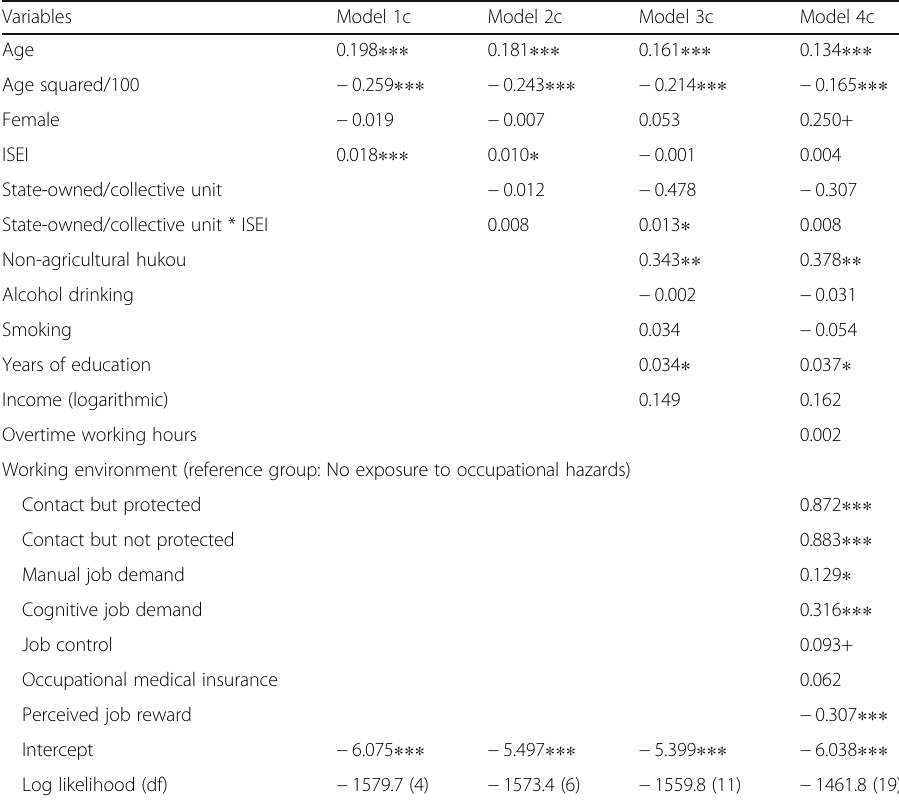
Table 7 Logit models of occupational status and working conditions on self-reported occupational diseases ( N = 3940) Variables Model